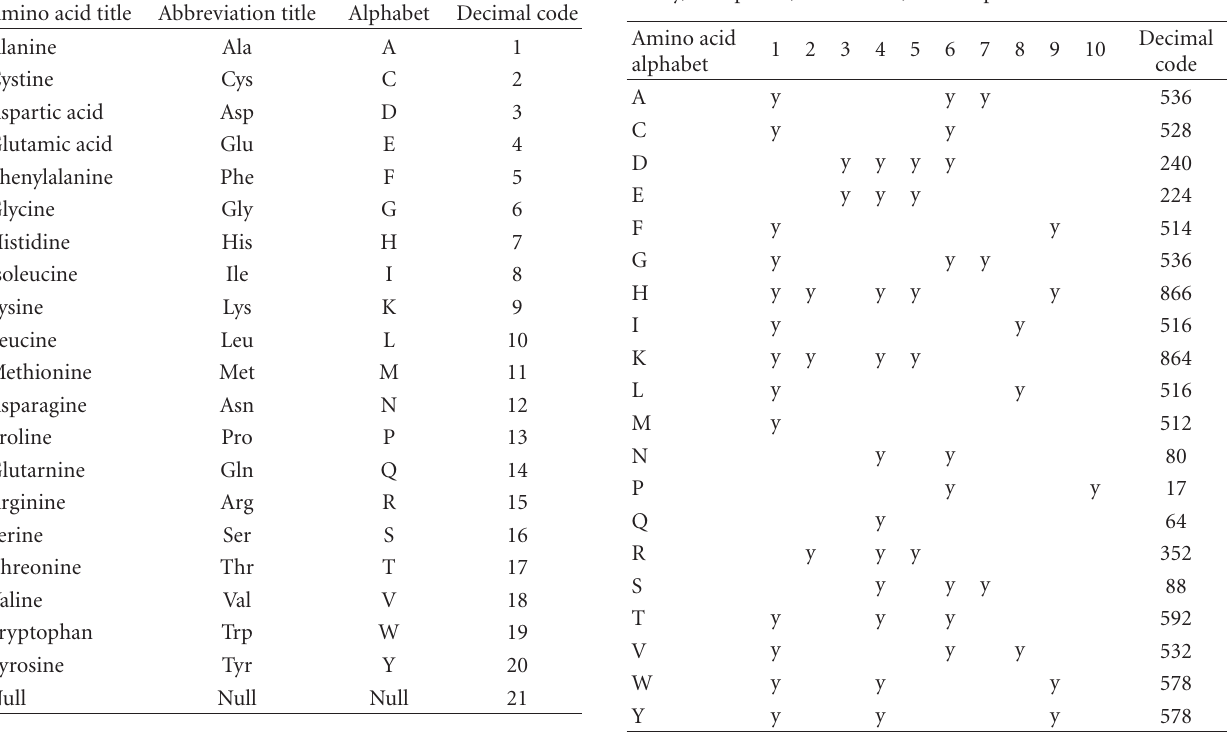
Table 4: Properties of amino acid residues of the second subsystem: 1: hydrophobic, 2: positive, 3: negative, 4: polar, 5: charged, 6: small, 7: tiny, 8: aliphatic, 9: aromatic, and 10: proline.